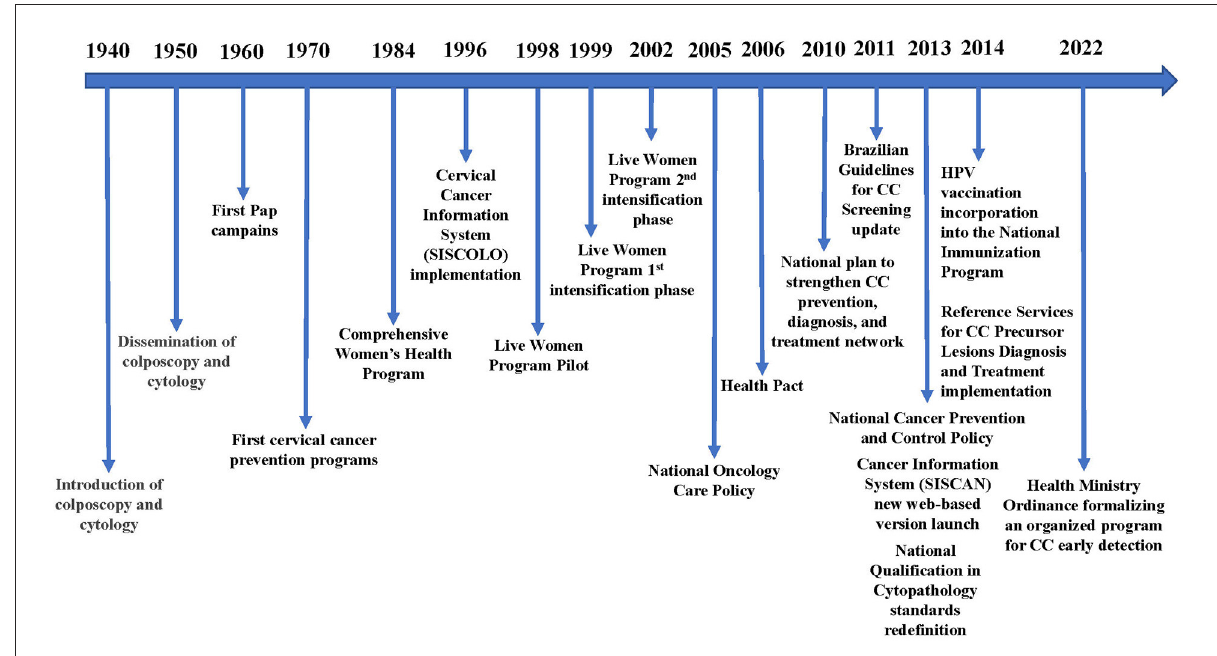
FIGURE1 Timeline of cervical cancer prevention actions in